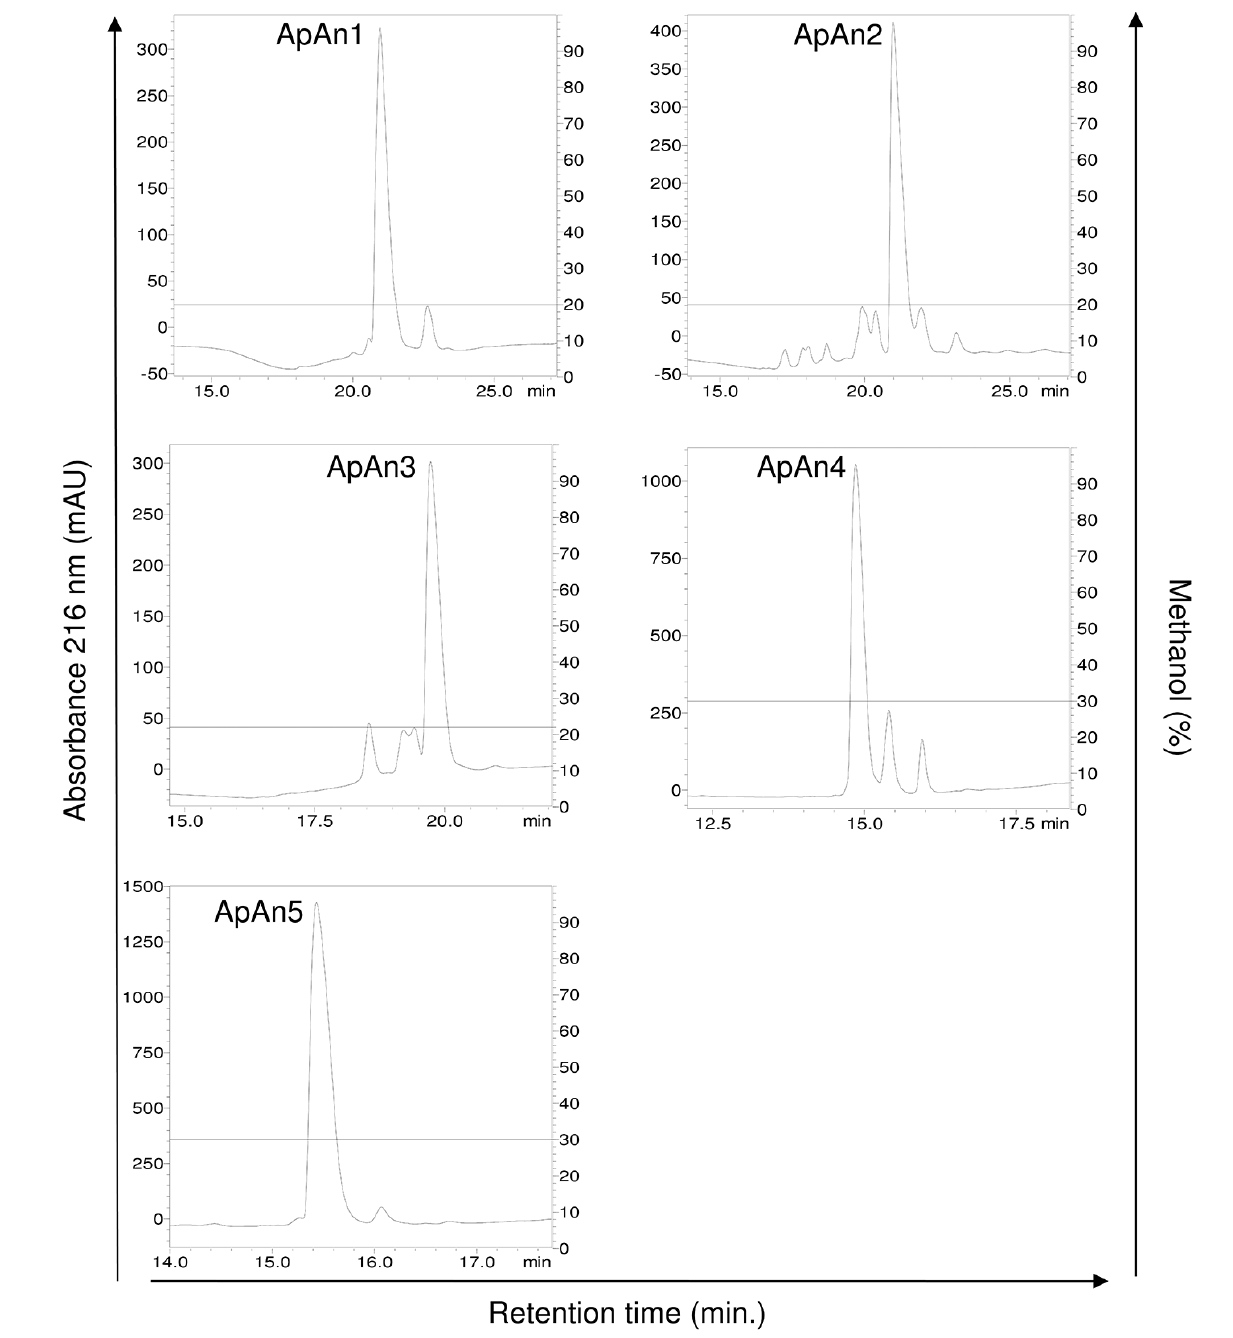
Figure 3. Rechromatography (step 3) of ApAn1, ApAn2, ApAn3, ApAn4 and ApAn5 fractions by RP-HPLC on a C18 column with optimized methodology (for ApAn1 to ApAn3: linear gradient from 0 to 20% solvent B in 10 min and 20% B of 10 to 40 min; for ApAn4 and ApAn5: linear gradient from 0 to 30% B in 10 min and 30% B from 10 to 40 min). Solvent B: 0.24% TFA v/v in